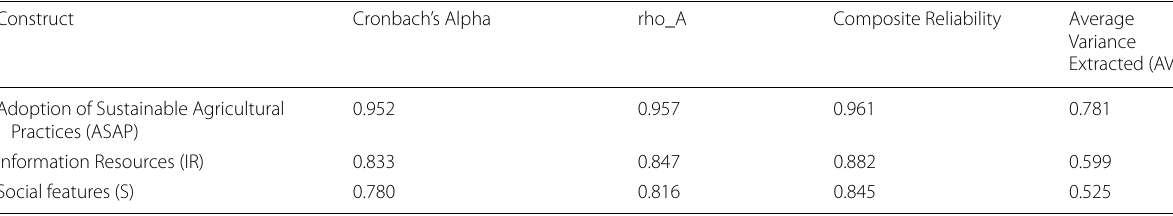
Table 4 Construct reliability and validity